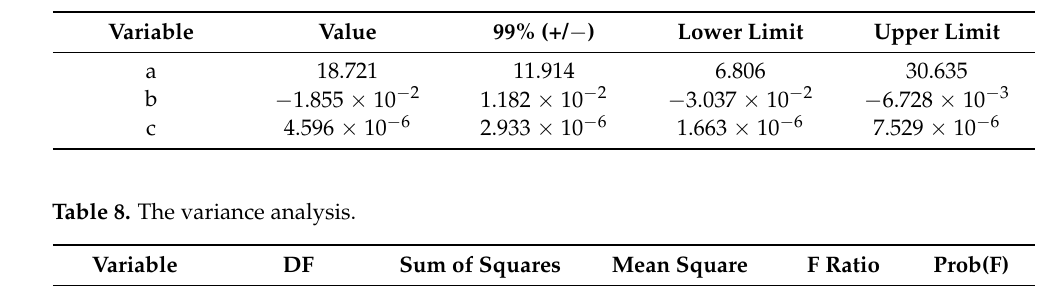
Table 7. Values of the coefficients of the mathematical model for a 99% confidence interval of the function.